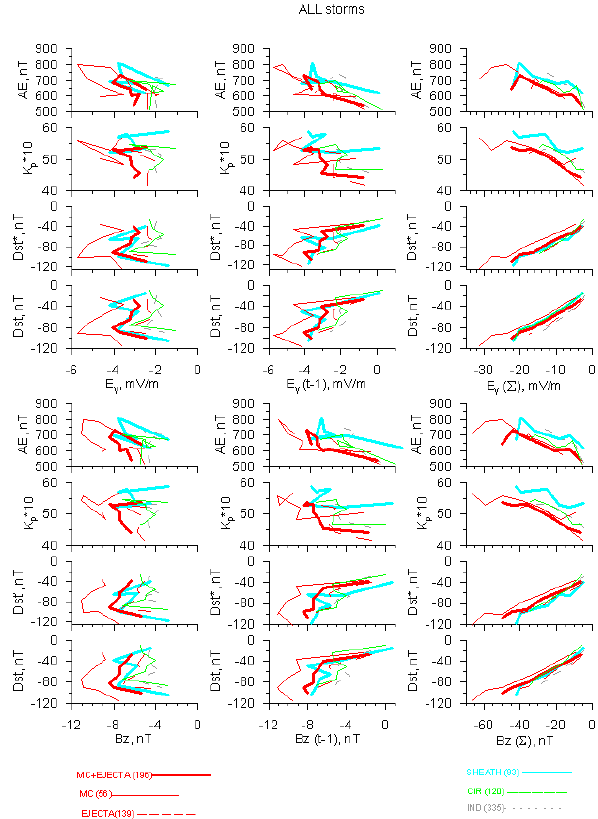
Fig. 7. Time evolution of Dst,Dst ∗ ,Kp and AE indices during time evolution of Bz and Ey for time interval of ”0” - ”6” using 3 procedures (see text): (1. Left column) simultaneous measurements, (2. Second column) 1-h displaced measurements, and (3. Right column) dependence of indices on integral value of sources.